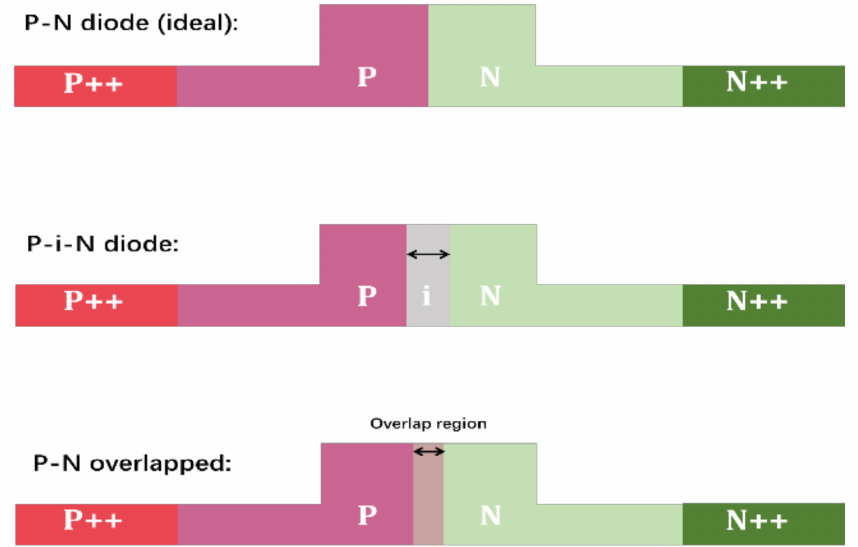
Figure 8. Two fabrication variation scenarios of the diode.